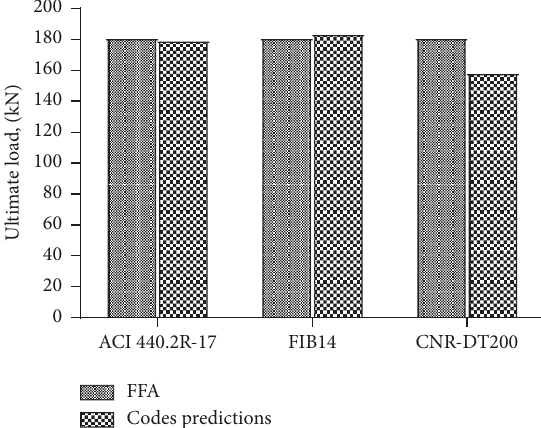
Figure 19: Ultimate load comparison between FEA and theoretical values for beam